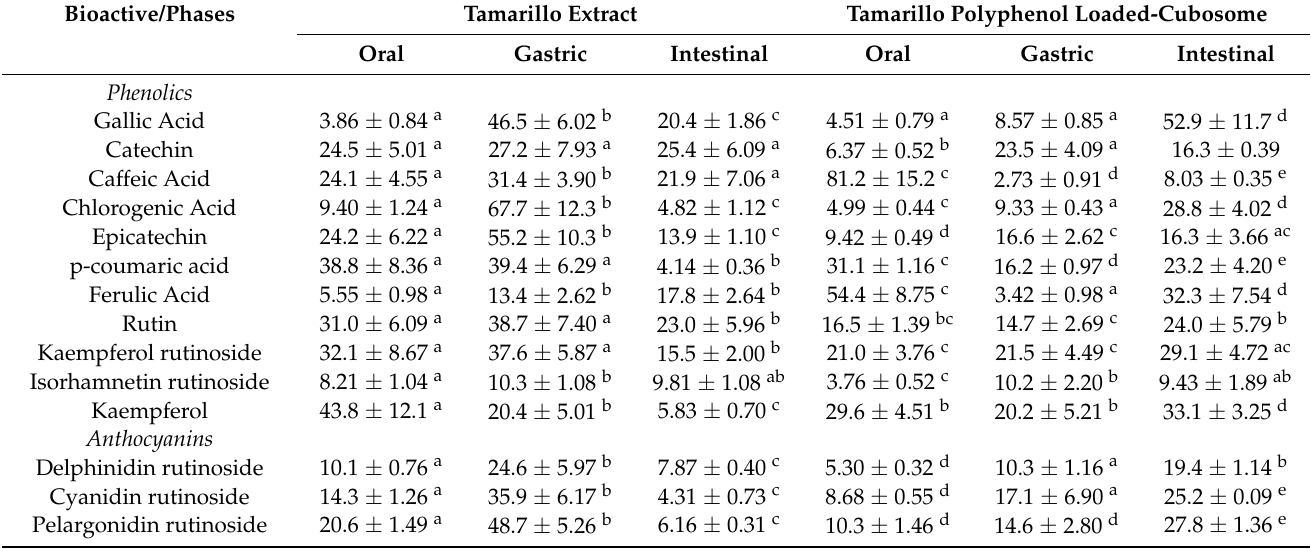
Table 1. Phenolics and anthocyanins in tamarillo extract and tamarillo polyphenol loaded-cubosome released during three stages of in vitro